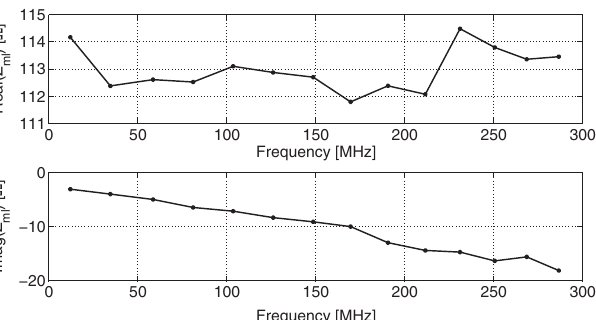
=c for the frequencies where (cid:1) ml L ml ¼ FIG. 11. (cid:5) ml L ml and v g (cid:2) ð 2 k þ 1 Þ = 2 ; c is the light velocity in vacuum.